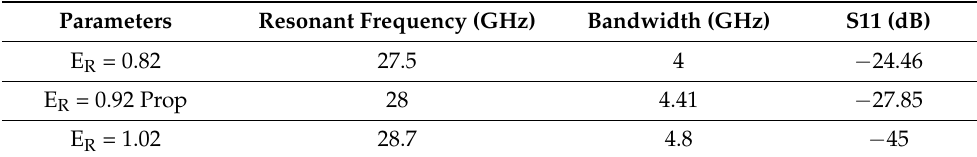
Figure 6. Reflection coefficient concerning E R . Table 4. Antenna simulation results of patch parameter (E R ).